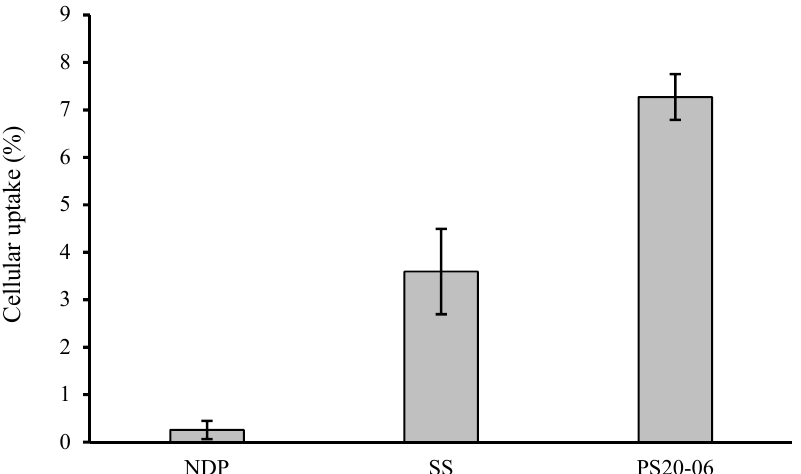
Figure 7. Relationship between the polar component and percentages of drug dissolved (20 and 120 min) at polysorbate concentrations of ( a ) 0.1%, ( b ) 0.3%, and ( c ) 0.6%.